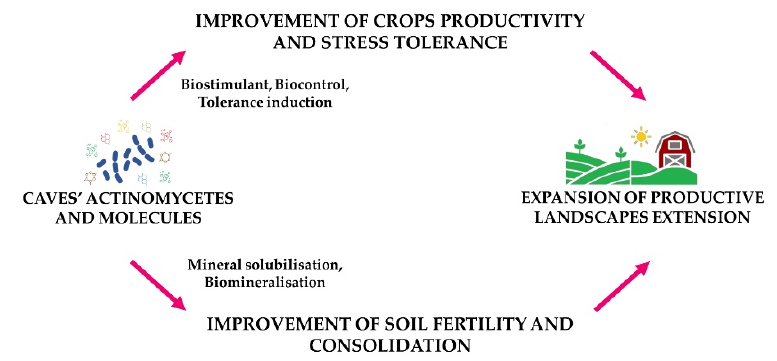
Figure 3. Schematic summary of the caves’ productive landscape expansion.